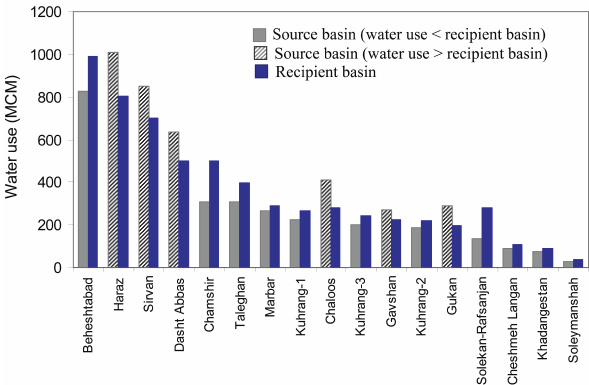
Fig. 8. Comparison of the volumes of water use in the recipient basin and in the source basin for a given amount of wheat pro- duced in the two basins. The water use in recipient basin is real water transfer and in the source basin is virtual water that could be transferred via wheat export to the recipient basins of major water transfer projects in